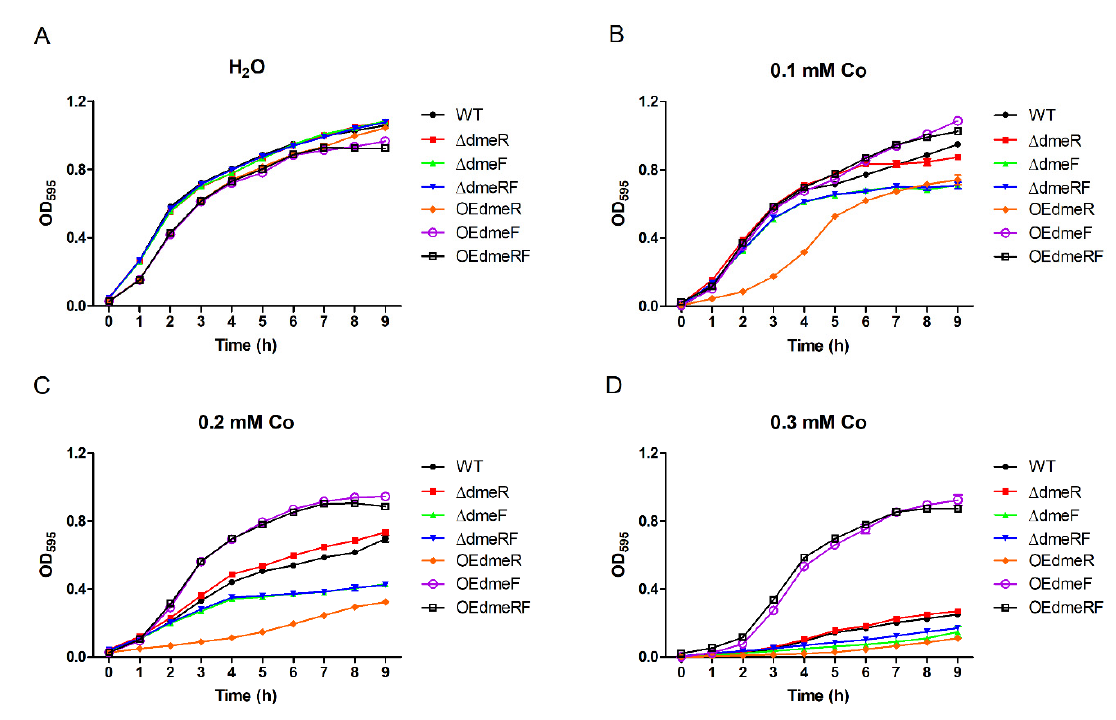
Figure 4. Growth curves of the V. parahaemolyticus strains grown in the absence of Co ( A ) or in 0.1 mM ( B ), 0.2 mM ( C ), or 0.3 mM ( D ) solutions of Co. The experiments were performed at least three times; the results represent the means and SD from three wells in a representative experiment.